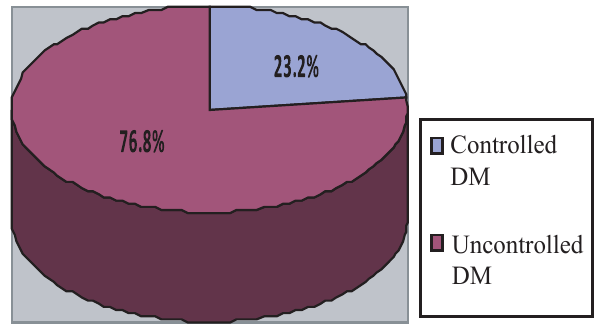
Fig 2. Status of diabetes on admission (n=95)